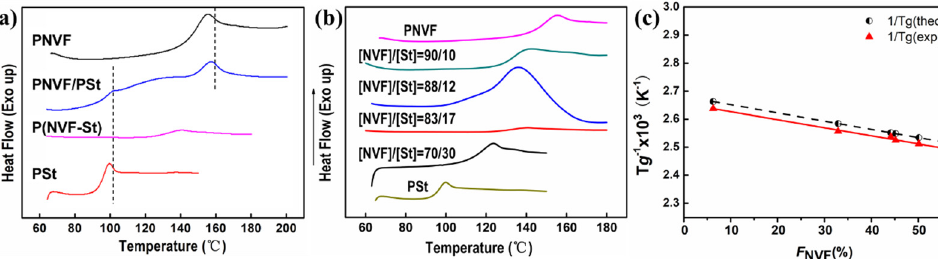
Table 1. Composition and T g of N -vinylformamide (NVF-St) copolymers *.